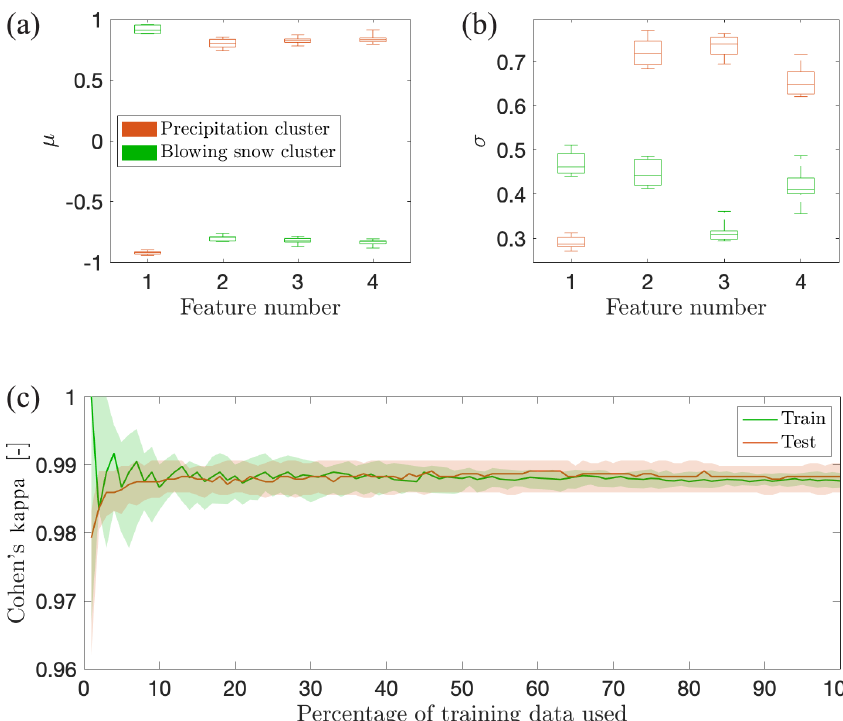
Figure 8. (a, b) Stability of the parameters µ and σ (diagonal entries of (cid:54) ) for the two Gaussian components. The boxplots show the distributions of these parameters for each dimension, after fitting the GMM on a 10-fold random split of the training set. The feature number follows the order given in Table 2. (c) Learning curves for the fitted GMM, showing the evolution of the train and Cohen’s kappa test as a function of the proportion of the training samples used. The shaded areas correspond to the 25–75th percentile range computed over 40 iterations of 70%–30% random train-test splitting, and the bold lines are the medians.